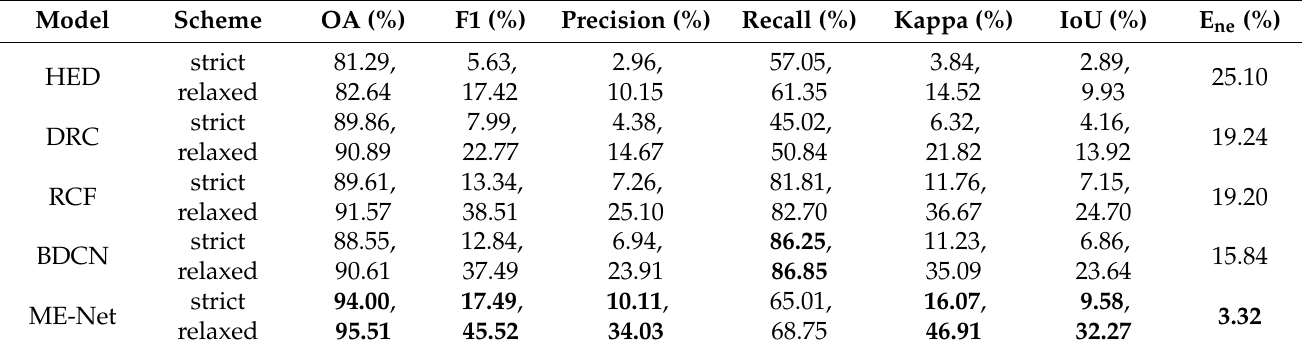
Table 4. Evaluation results on the test set of Inria dataset. Each cell has the value with strict and relaxed metrics and the best values are masked as bold (the lowest E ne indicates the clearest and crispest result).